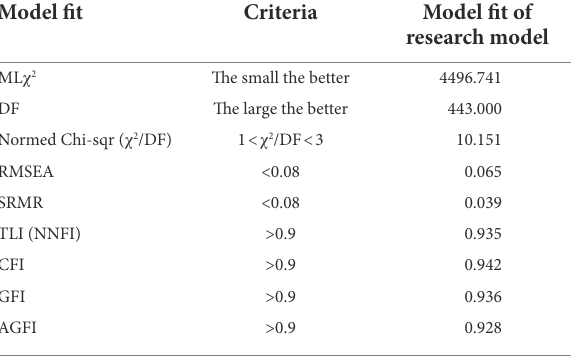
TABLE 4 Model fit criteria and the test